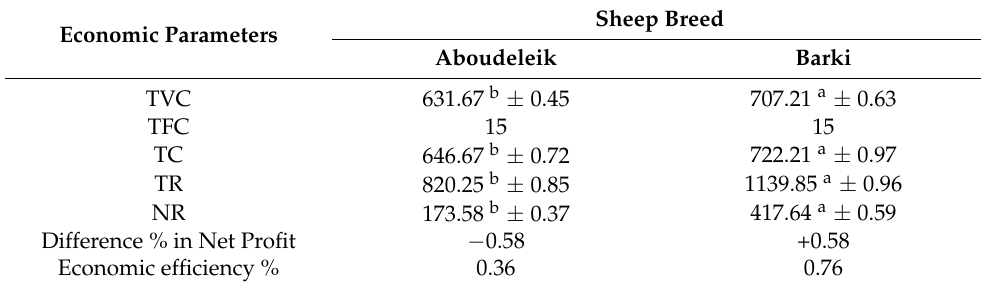
Table 6. Economic evaluation criteria of Barki and Aboudeleik lambs.